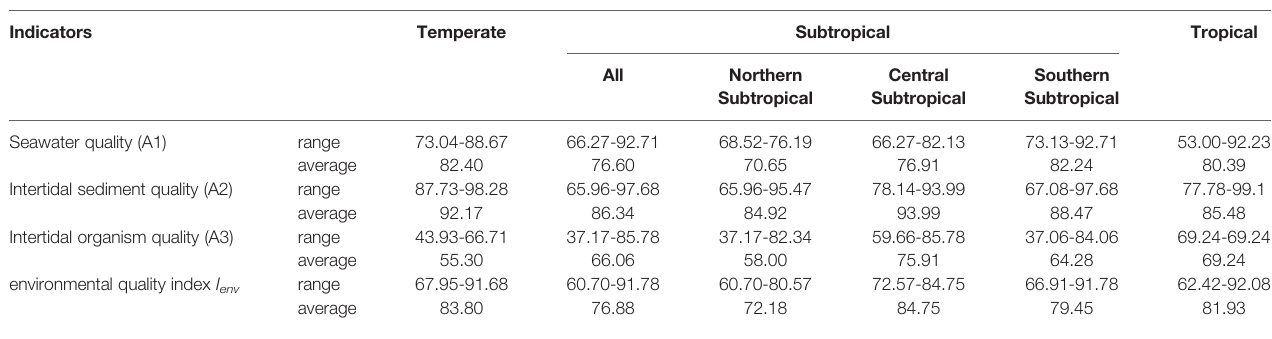
TABLE 4 | Environmental quality assessment